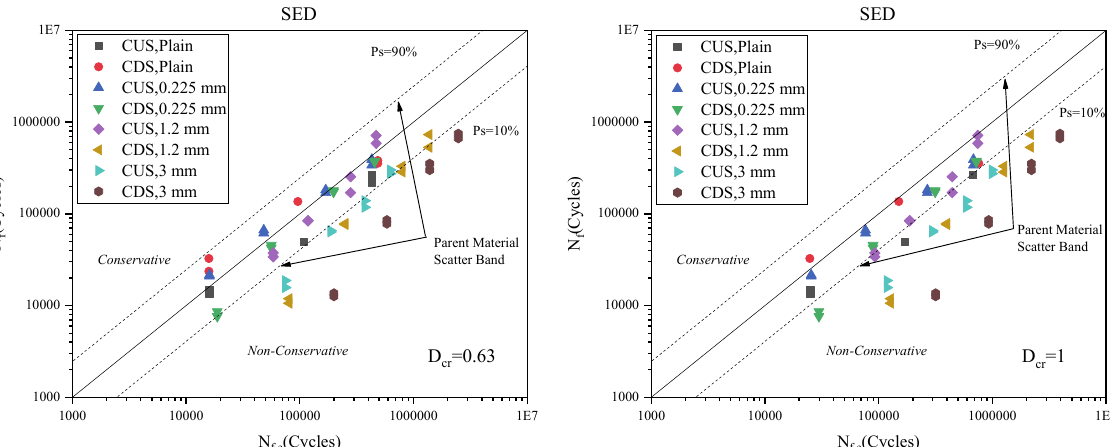
Figure 6 : The accuracy of SED in estimating the fatigue lifetime of the notched samples under two critical value of the damage sum, D cr . (a) D cr =0.63. (b) D cr